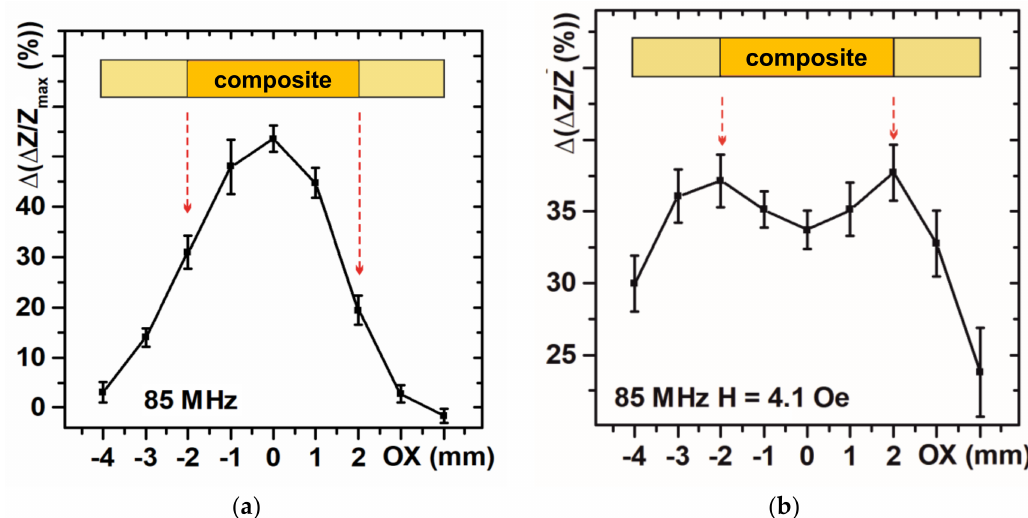
Figure 7. GMI response at the different positions of the magnetic insert: maximum MI ratio ( a ), in the sensitive range of the magnetic field ( b ). Arrows point to the points that correspond to the magnetic insert